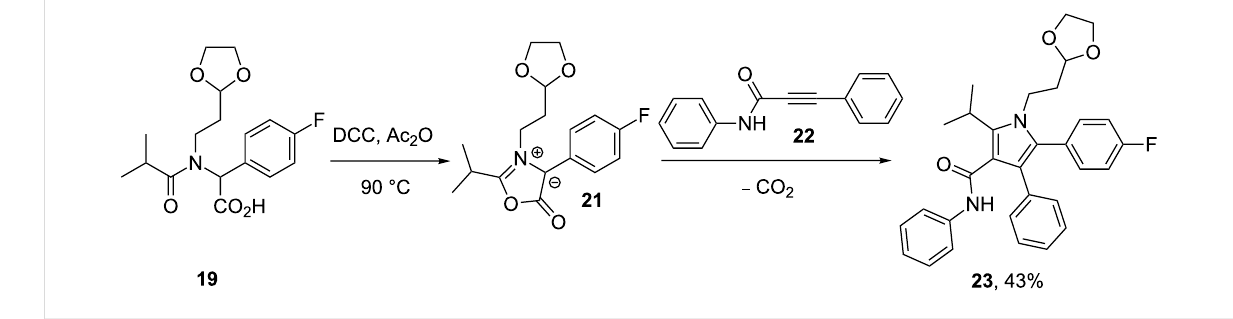
Scheme 4: Formation of the pyrrole core of atorvastatin via [3 + 2] cycloaddition.